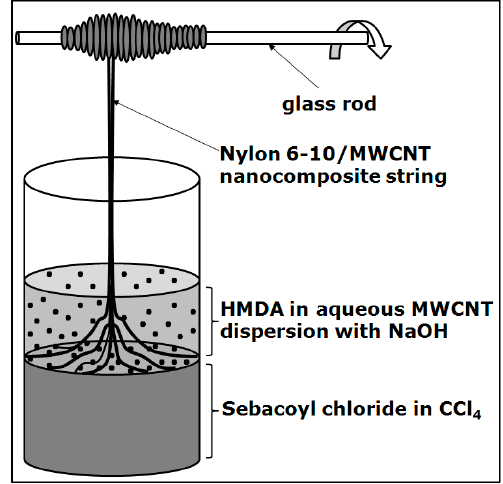
Figure 4. Schematic showing the preparation of nylon 6–10/MWCNT composites via in situ interfacial polycondensation of